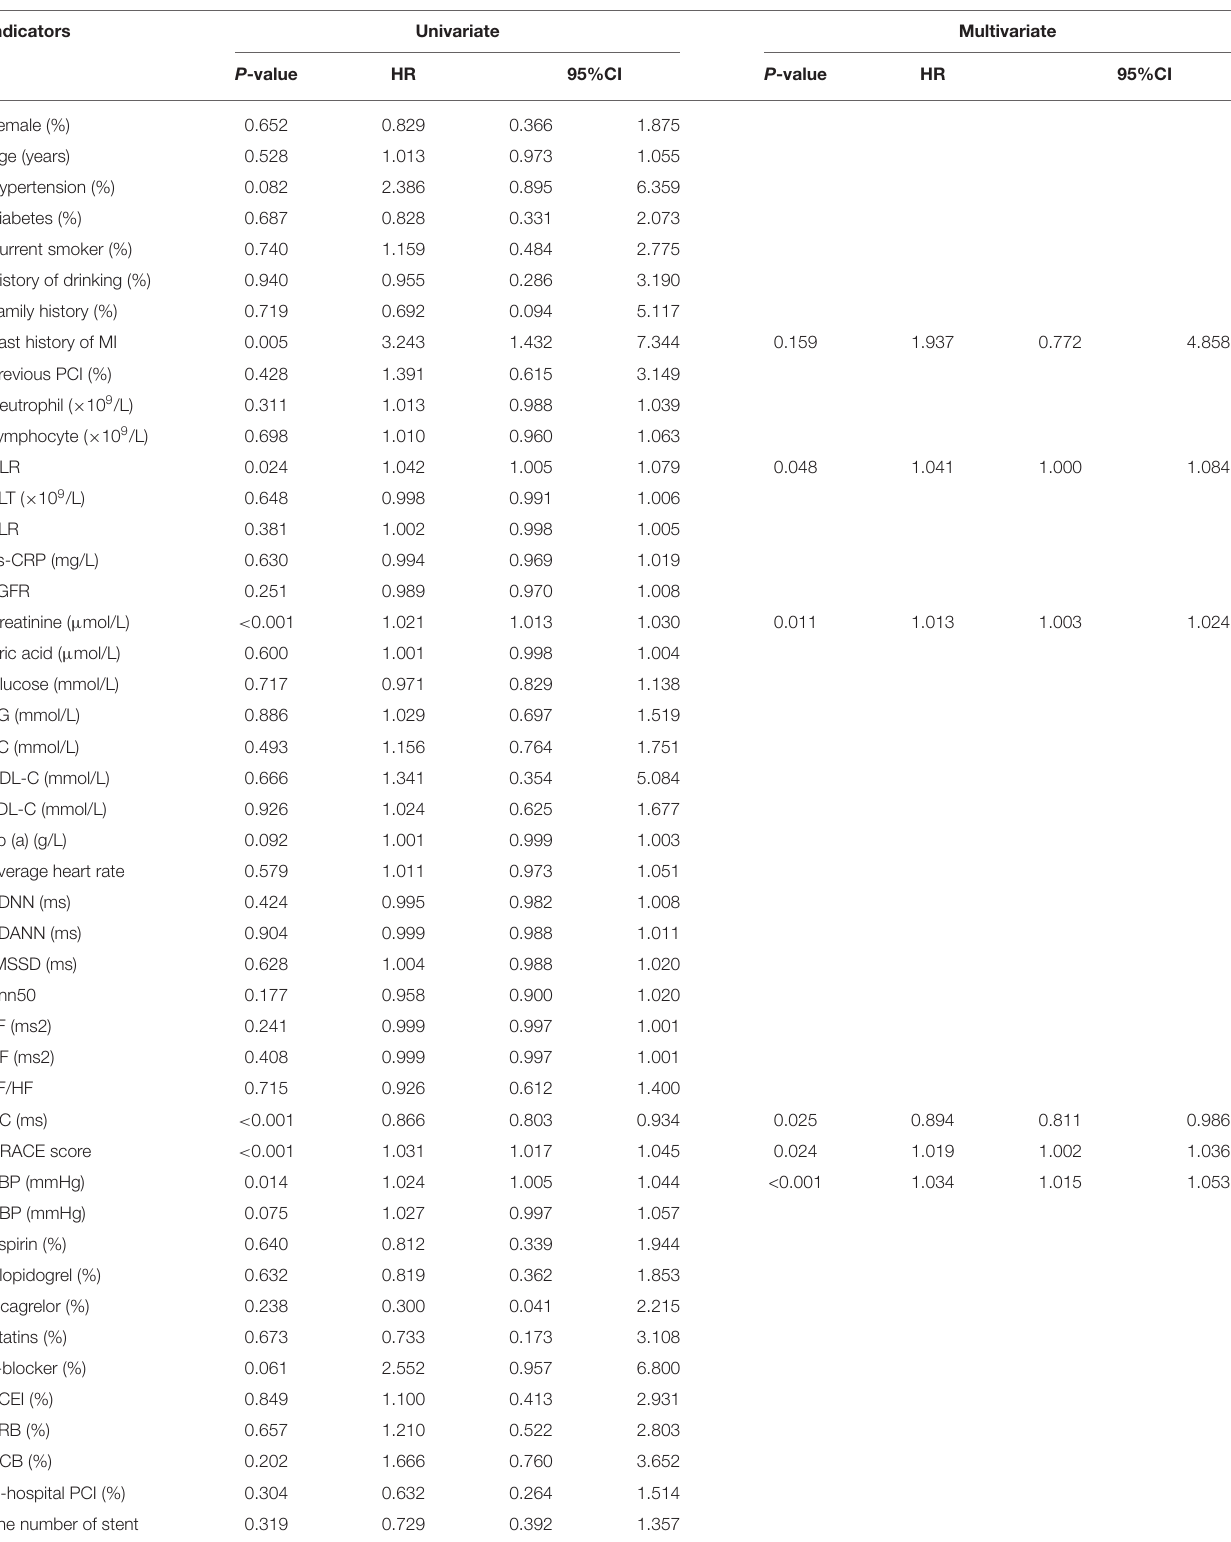
TABLE 4 | Predictors of the occurrence of MACEs in patients with Non-ST segment elevation myocardial infarction/ unstable angina (NSTEMI/UA): results of univariate and multivariate Cox-regression analyses. Indicators